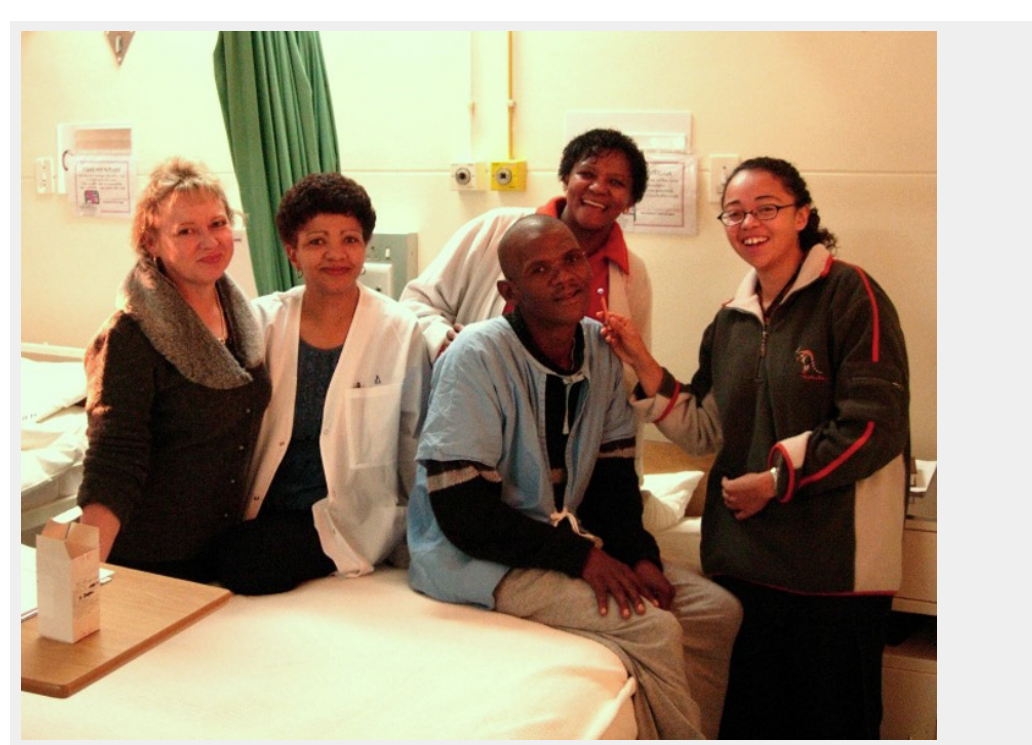
First tuberculosis patient treated with TMC207. TMC207 was the first of a series of new compounds to enter clinical testing. The image shows the patient sitting among the study team that dispensed TMC207 in Cape Town on 28 June 2005 for the first time to a tuberculosis patient. In 2011 TMC207 became available for compassionate use for patients with highly resistant tuberculosis. (The patient has given written informed consent for